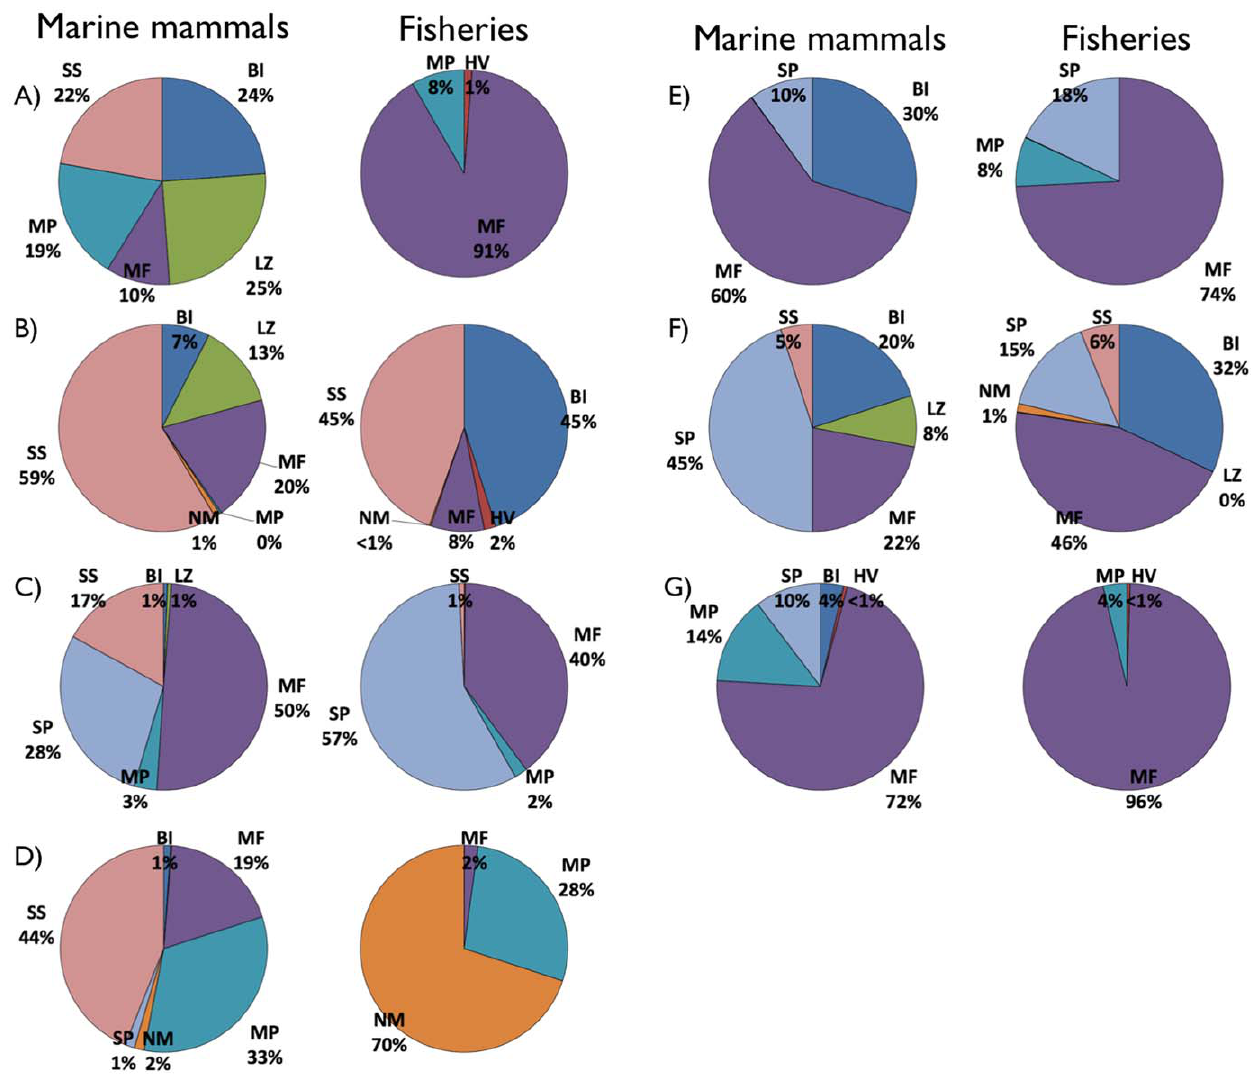
Figure 1. Location of the ecosystem modeled with Ecopath and used for this analysis.